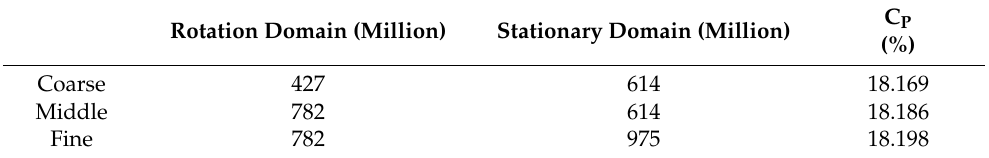
Table 2. Performances of grid independency study ( λ =